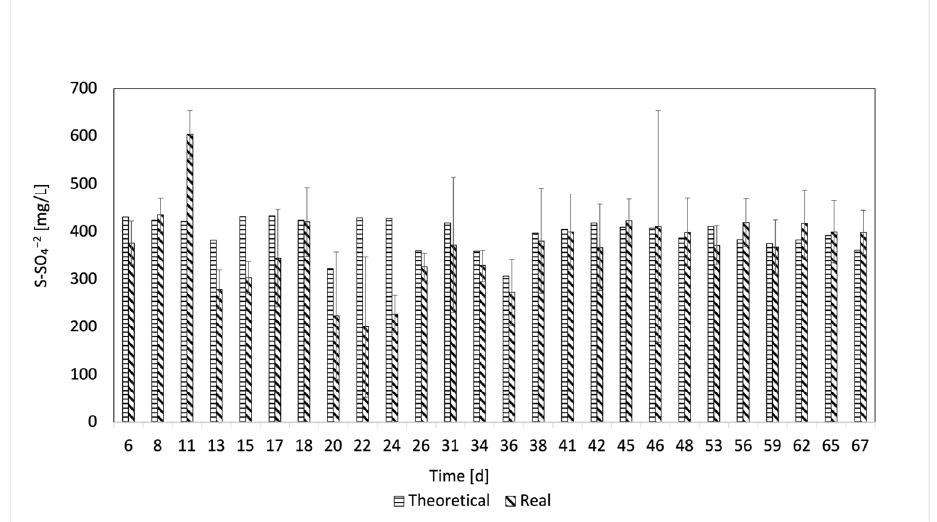
Figure 3 . Sulfate balance in the second Autotrophic denitrification (aDN) enrichment.